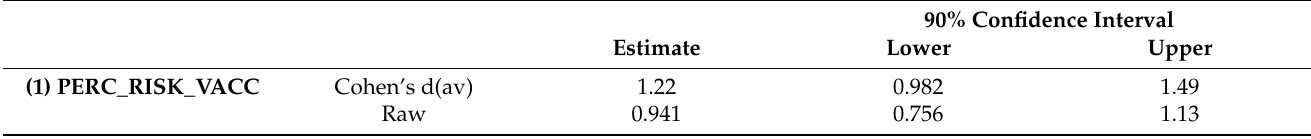
Table 5. Trust in one’s decision and decision to vaccinate against COVID-19.